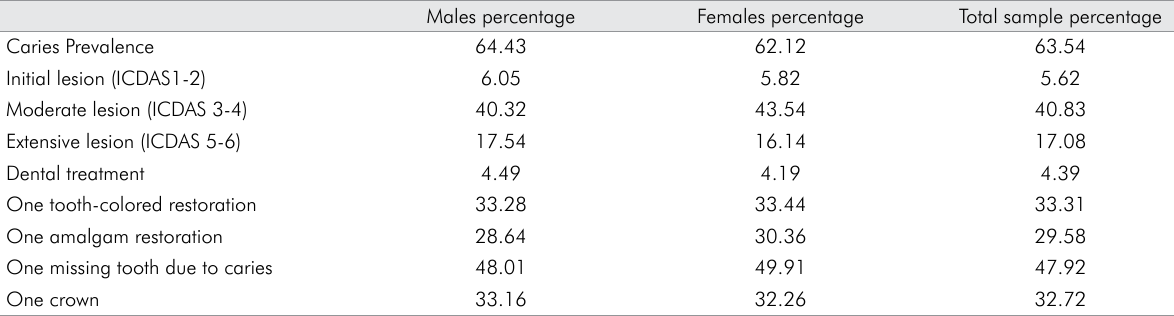
Table 1. Sample distribution of clinical data by